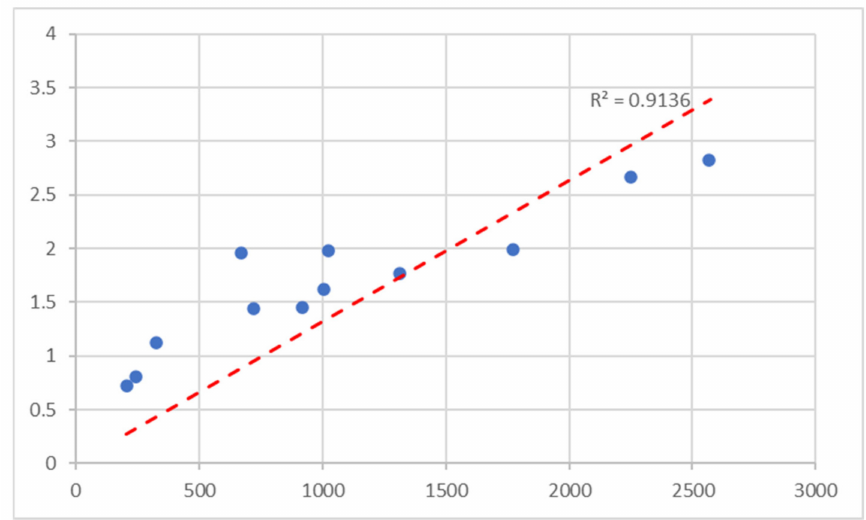
Figure 19. Correlation Graph, where the Y -axis is planimetry and the X -axis is the number of white pixels taken from our